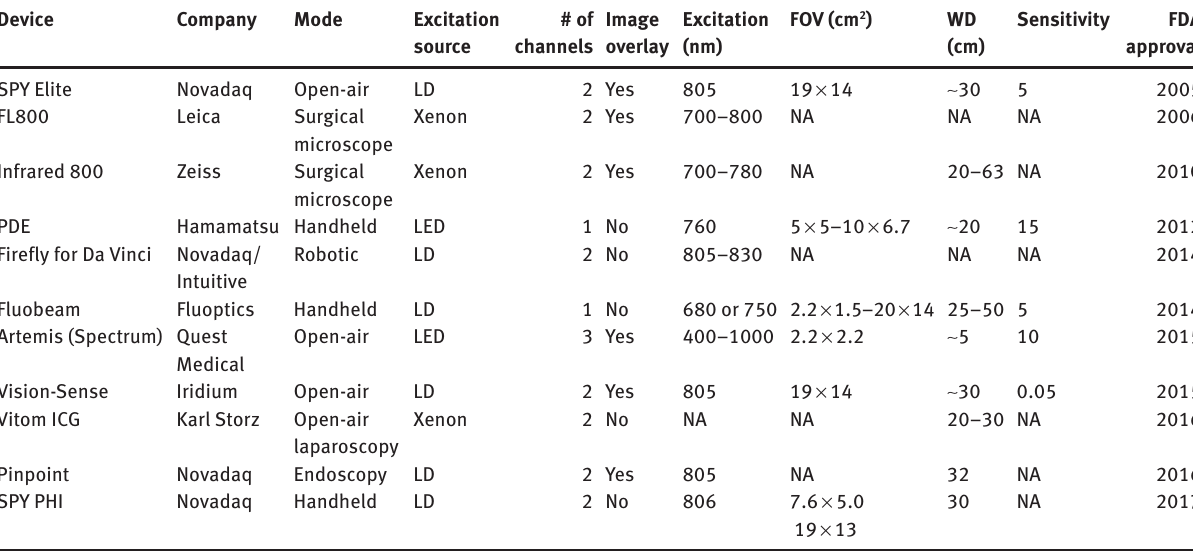
Table 1: Commercially available open-air imaging systems for image-guided surgery [12, 14, 54]. Device